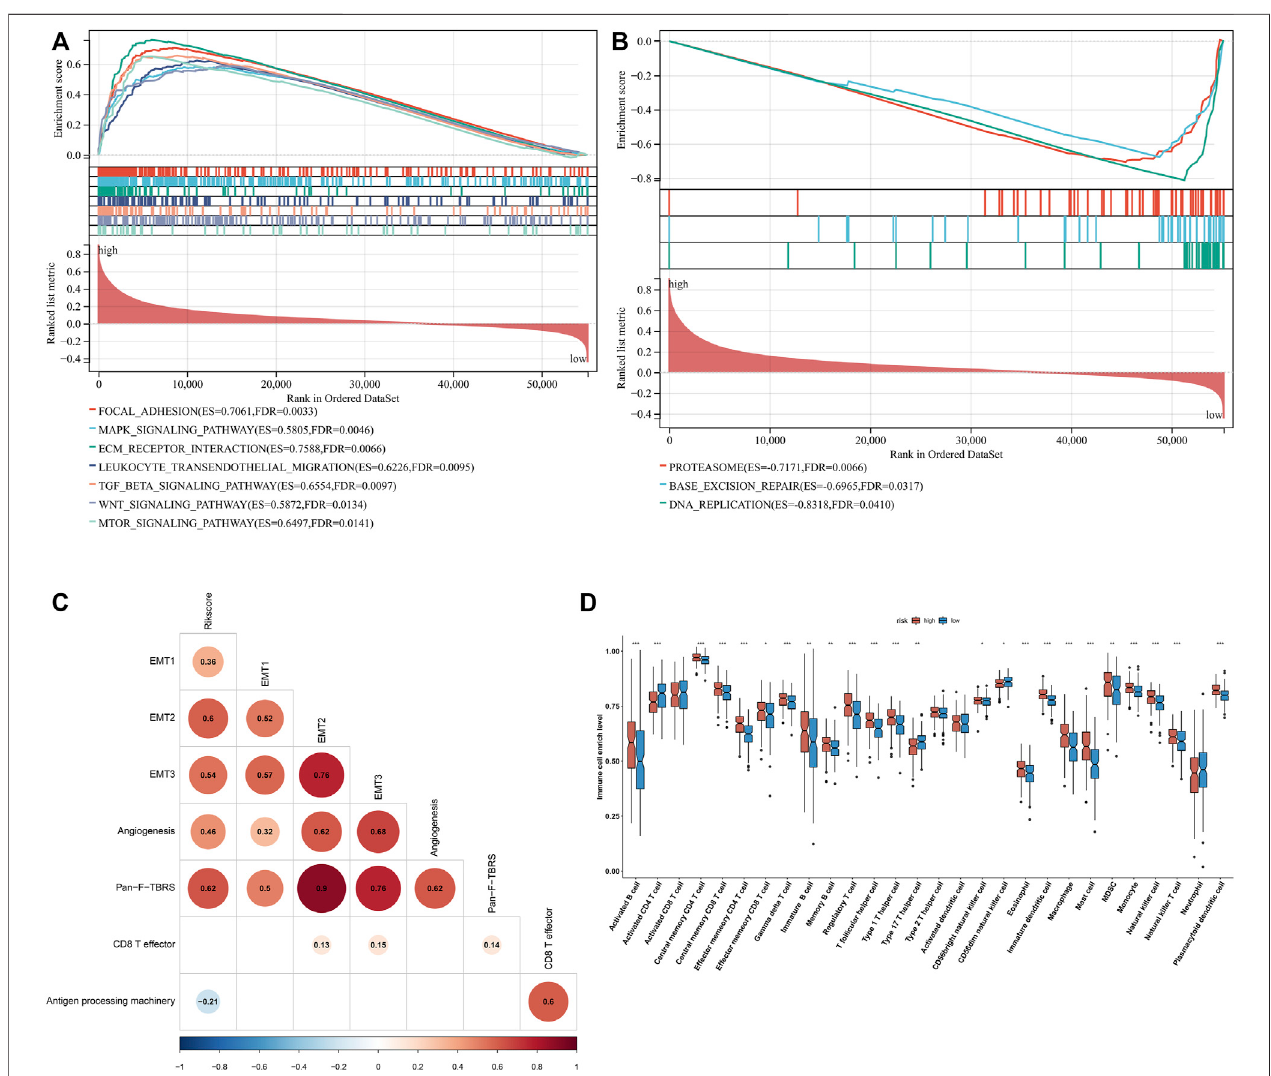
FIGURE 6 | Exosome-based gene signature is linked to stromal activation and immunosuppression in GC. (A) GSEA showing the signaling pathways positively linked to the exosome-based gene signature. (B) GSEA showing the signaling pathways negatively associated with the signature. (C) Associations of the signature with stromalandimmuneactivationpathwaysthatwerequanti fi edbythessGSEAapproach. (D) Comparisonsoftherelativeabundancelevelsof28immunecelltypesinthe high-risk group relative to the low-risk group. p p -value < 0.05; pp p -value < 0.01; and ppp p -value < 0.001.